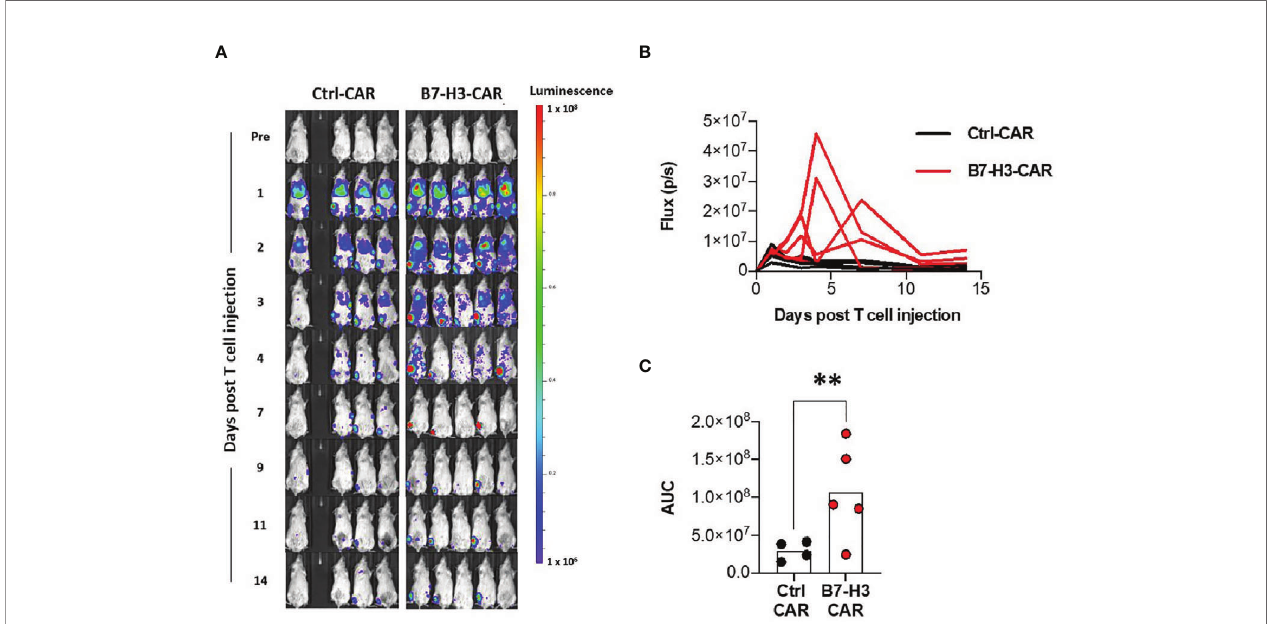
FIGURE 4 | CAR T cell traf fi cking to orthotopic tumors. LM7 OS cells were embedded in highly-viscous collagen implanted into the tibia of NSG mice on Day 0. On day 28, B7-H3-CAR T cells expressing fi re fl y luciferase were injected via tail vein. Mice were then imaged with serial bioluminescence over the following 14 days. (A) Serial imaging of implanted mice over time. (B) Quanti fi cation of tibial implant site bioluminescence (total fl ux (p/s) per ROI) over time. (C) AUC calculation for B7- H3-CAR (N = 5) and Ctrl-CAR (N = 4) treated mice. One healthy T cell donor. Statistical analysis performed by student ’ s t test. **p <